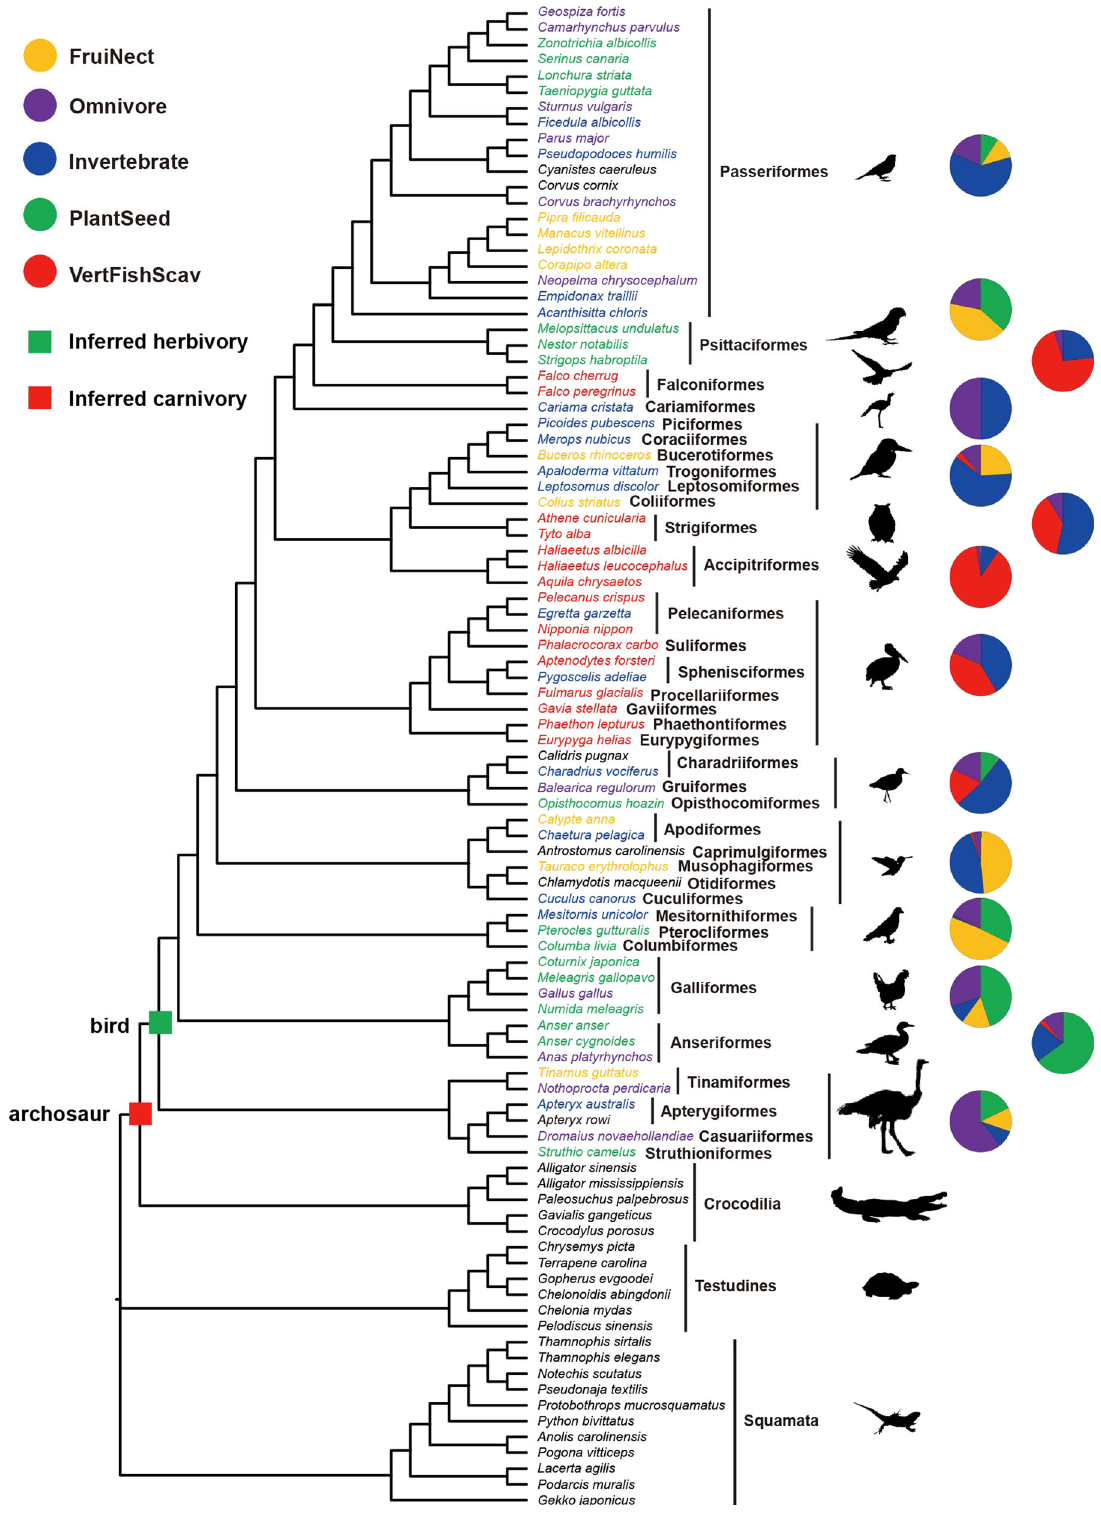
Fig. 1 Phylogeny and the diets of modern birds. Phylogenetic relationships of taxa used follow published studies 30,138 – 143 . Dietary categories of each bird species follow one published study 145 and are shown in different colors, and the bird species without dietary information available are shown in black. The dietary categories of avian clades based on the dietary data of a total of 9993 extant bird species are shown in pet charts. PlantSeed (plant and seeds), FruiNect (fruits and nectar), Invertebrate (invertebrates), VertFishScav (vertebrates and fi sh and carrion), and Omnivore (score of ≤ 50 in all four